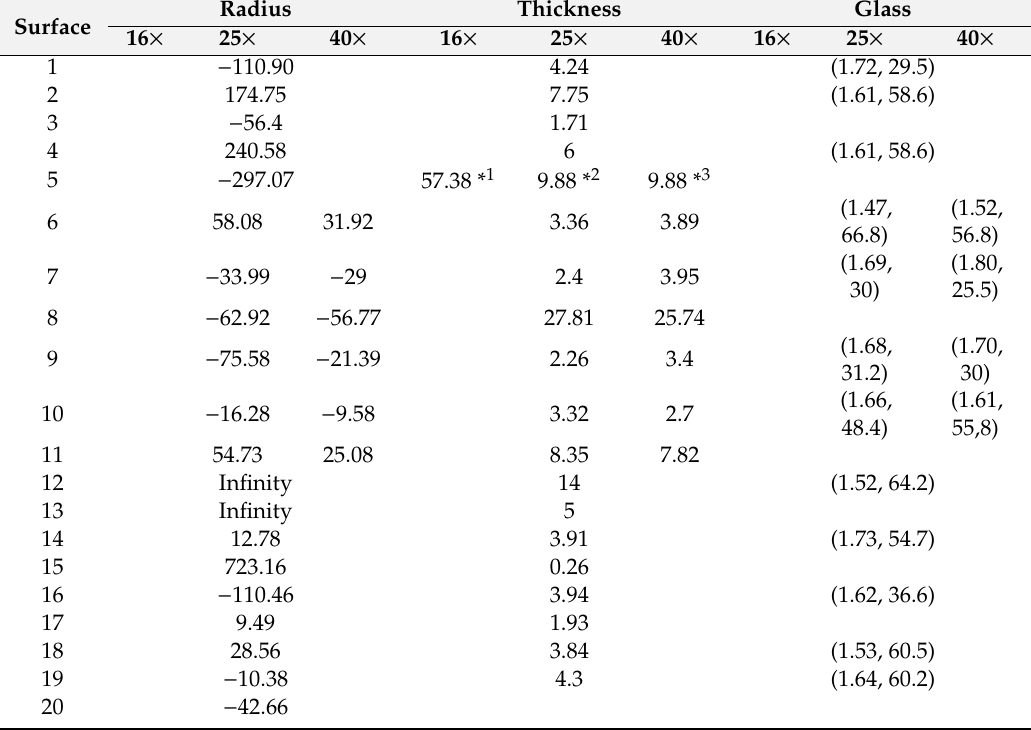
Table 2. Prescription for the DSLM